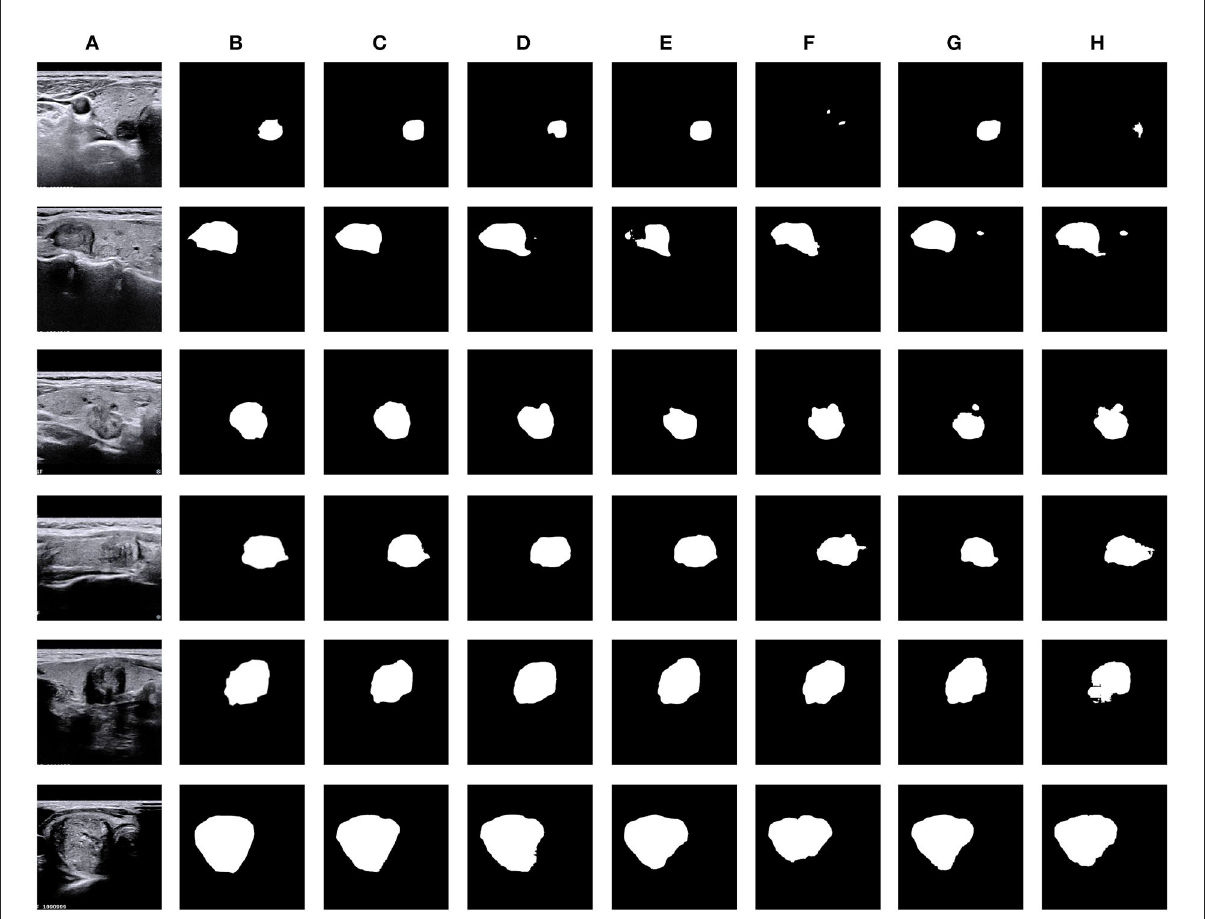
FIGURE6 Visual comparison of thyroid nodule segmentation results generated from five typical methods, including our N-Net. (A) Input, (B) GT, (C) Ours, (D) DeepLabV3, (E) M-Net, (F) PSP-Net, (G) AttU-Net, and (H)